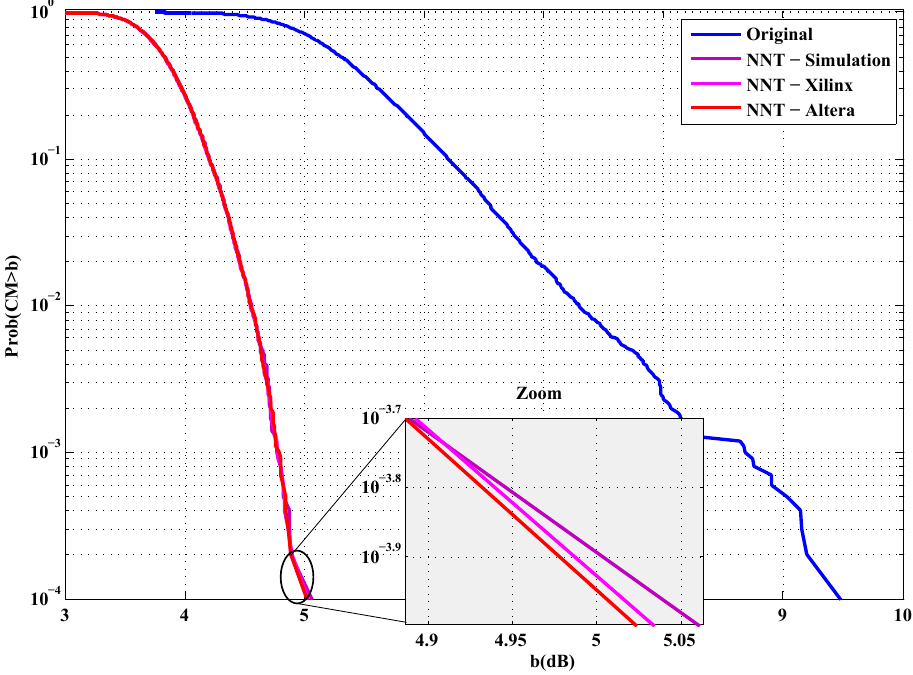
Figure 16. ECMA-368 cubic metric reduction in the case of QPSK modulation.